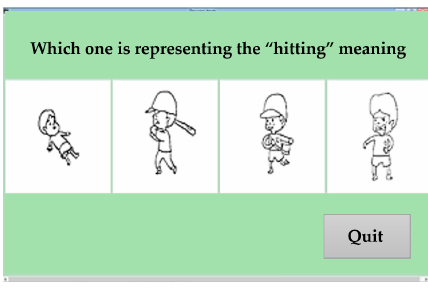
Figure 1. Screenshot of graphic symbol assessment.